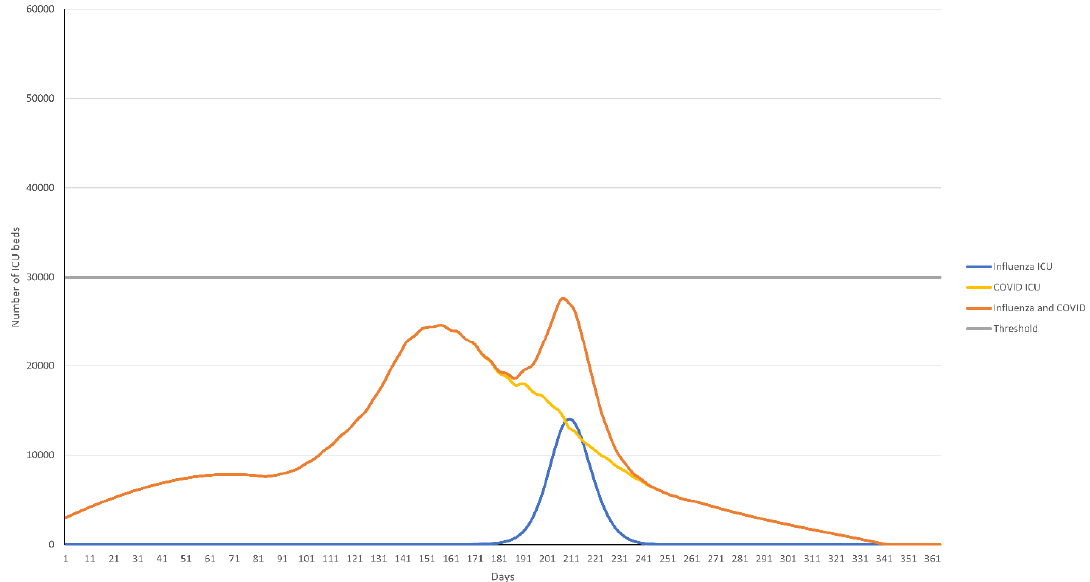
Figure 3. ICU bed occupancy over time for the base case scenario (QIVe for all age groups) where peak COVID-19 bed occupancy occurs 50 days before peak influenza bed occupancy and assuming an influenza vaccine coverage of 65%. Table 2. Sensitivity analysis evaluating the effects of reducing the probability of hospitalization, length of stay, and vaccine efficacy. Each parameter was varied to be 50% and 150% of base case assumptions. The acute hospital and ICU bed occupancy for high and low incidence influenza sea- sons are shown. Analysis assumes use of QIVe across all age groups and a vaccine coverage rate of 45%. Variable